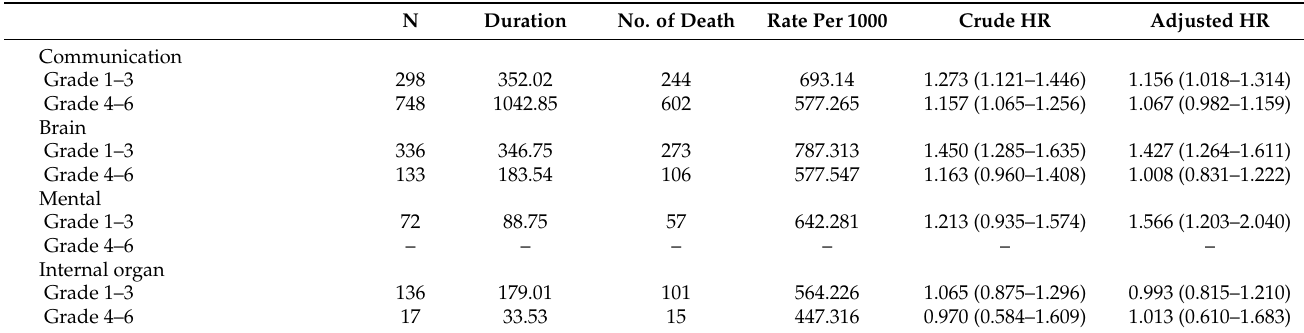
Adjusted for age, sex, income, endemic area, Charlson comorbidity index, seer stage.